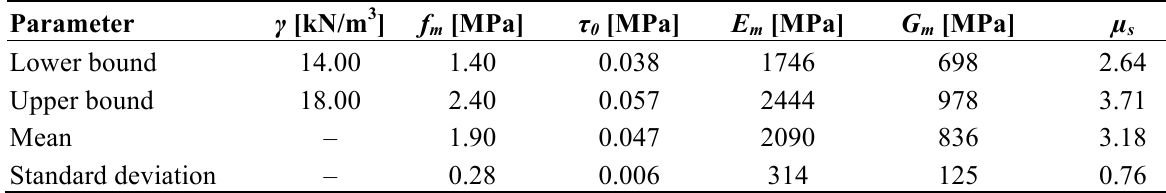
Table 1. Random properties and their statistics.